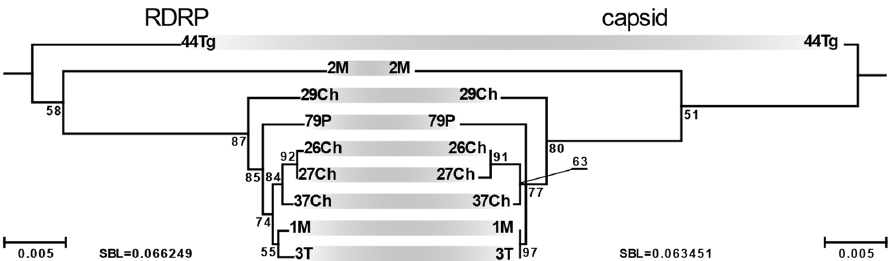
Figure 4. Comparison of RDRP and capsid subtrees for the LRV2 from L. major clade drawn to the same scale. SBL stands for the sum of branch lengths. Scale bar indicates the number of substitutions per site. Values at branches are bootstrap supports.